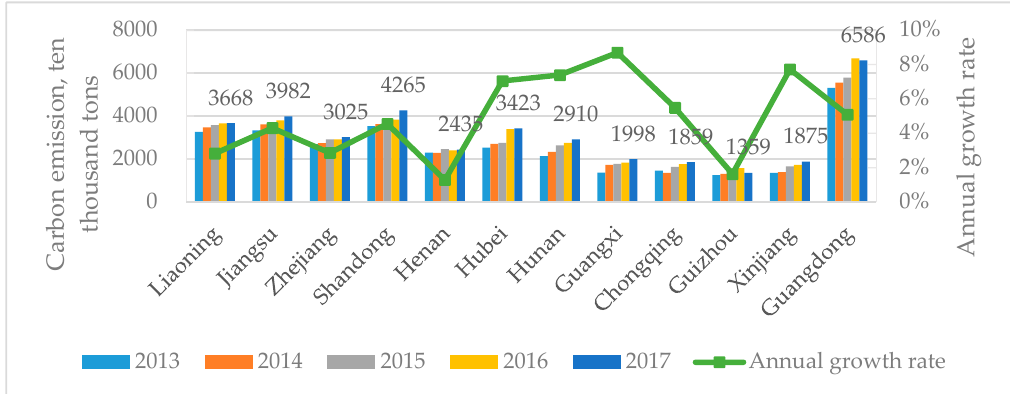
Figure 2. Carbon emissions (10 4 tons) for the logistics industry in the pilot regions from 2013 to 2017.